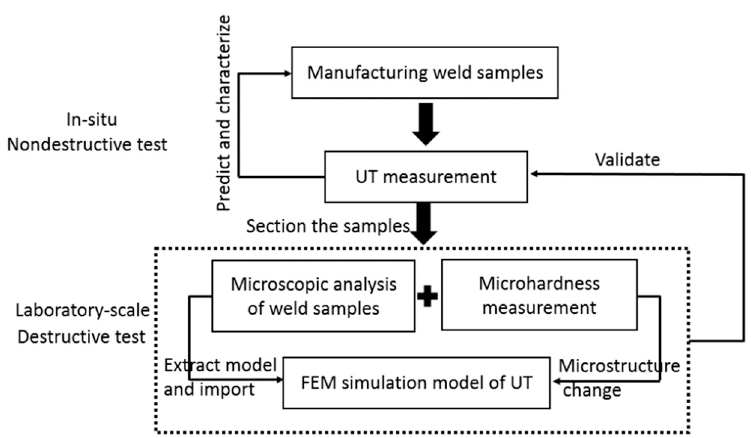
Figure 1. The connection of experimental results (UT and metallography) and numerical models (UT: Ultrasonic Testing, FEM: Finite Element Method).